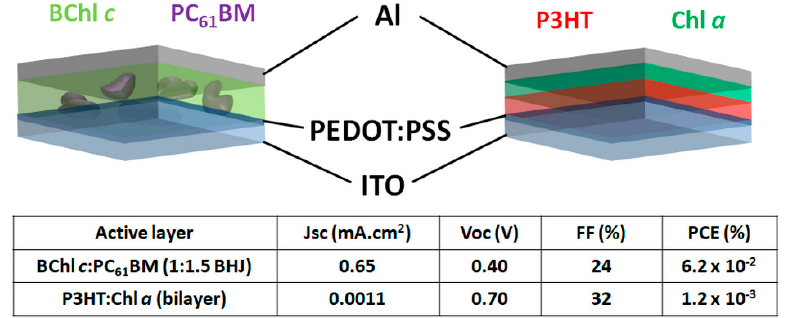
Figure 4. Schematic representations of the device architectures and photovoltaic performances of the devices prepared in References [23,24].